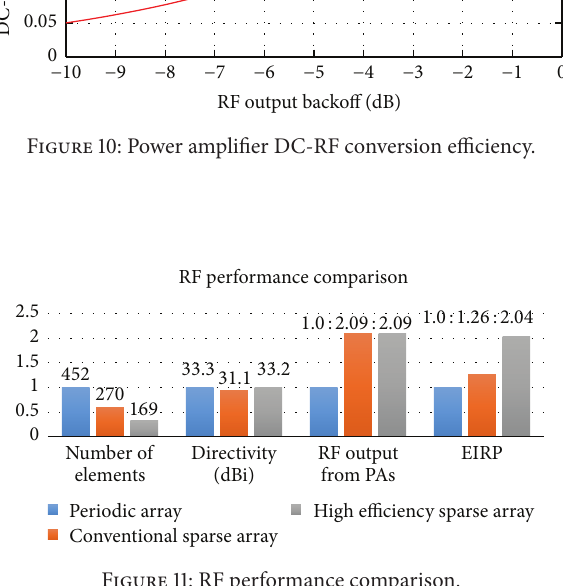
Figure 11: RF performance